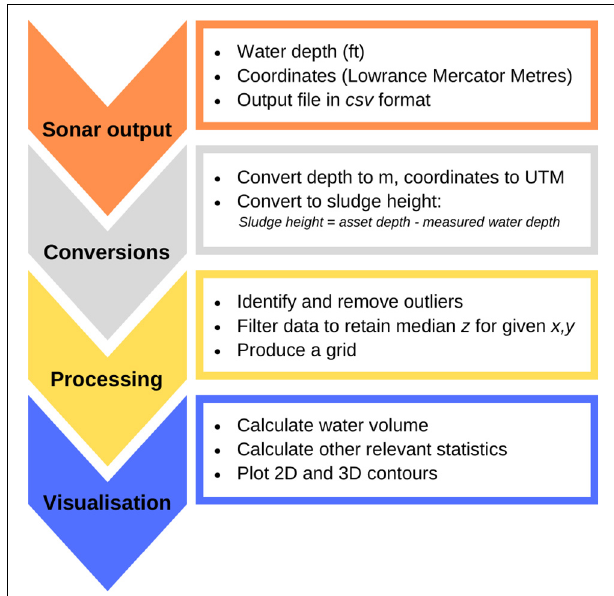
FIGURE 3 | Summary of the data processing required after profiles are collected with the ROV. These processing steps can be achieved manually, or automated using a